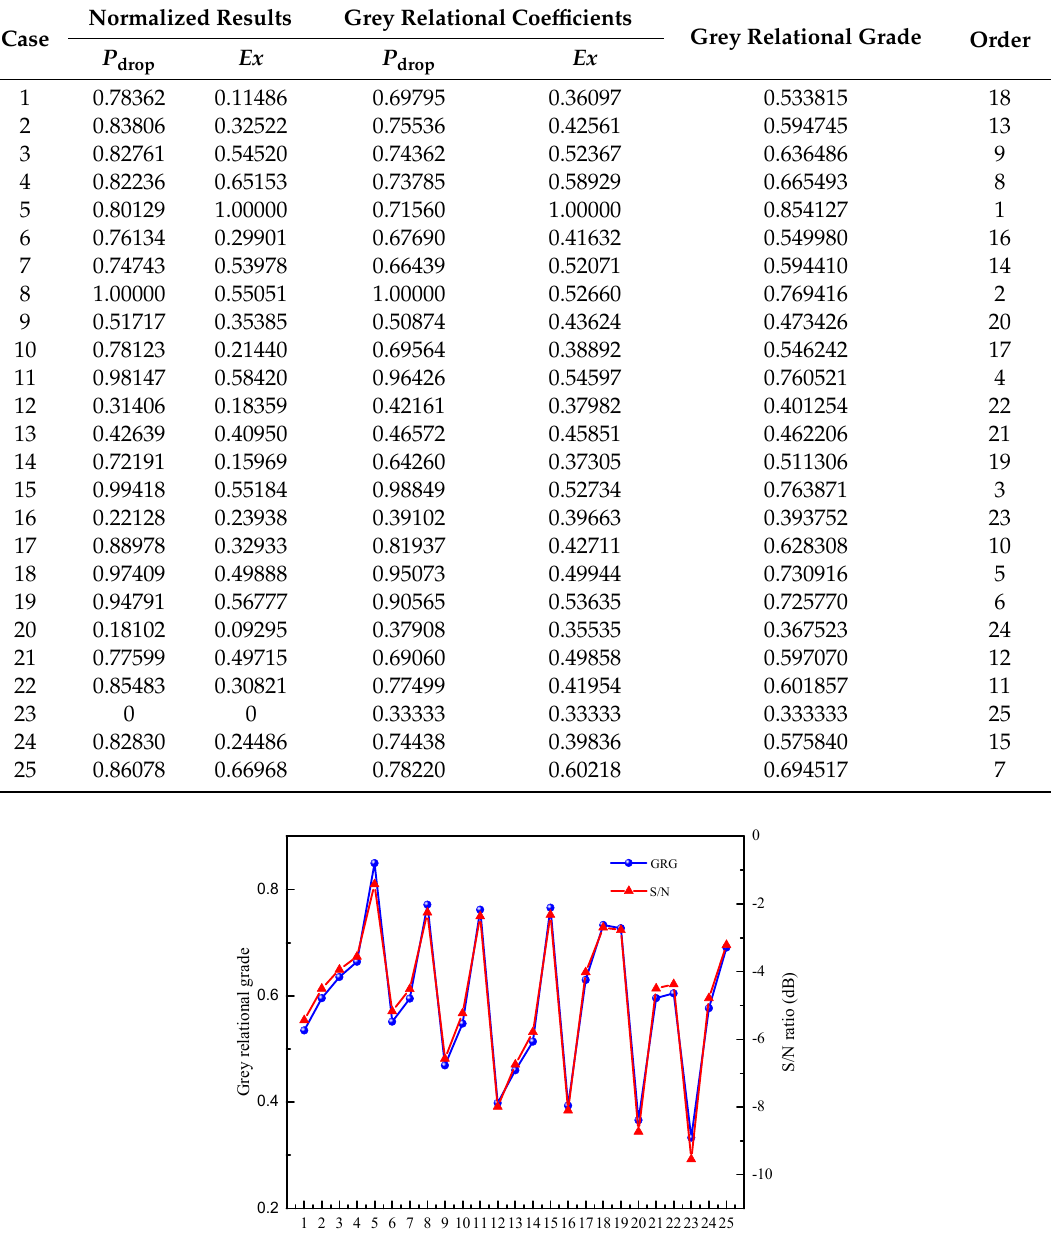
Table 12. Normalized results, grey relational coe ffi cient, grey relational grade, and order.